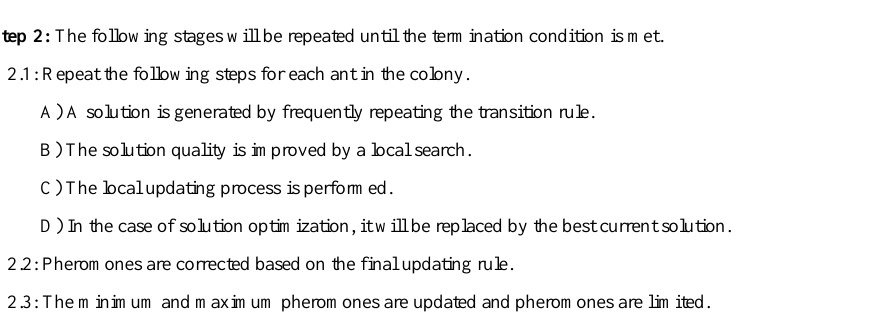
Table 1. The Structure of the Ant Algorithm